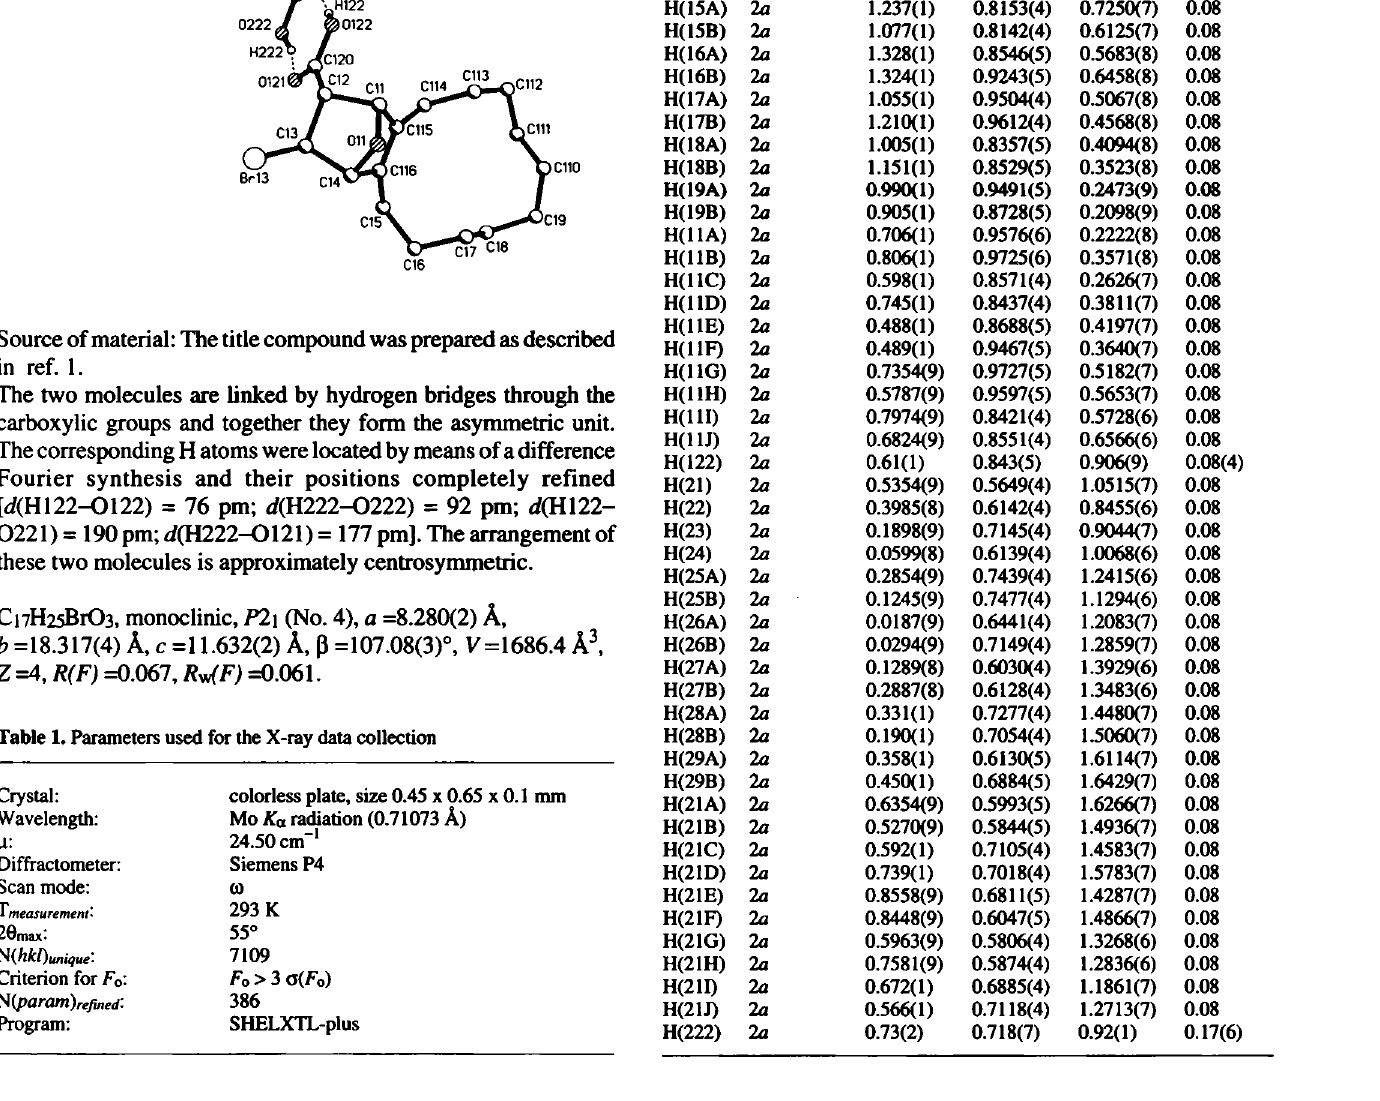
Table 2. Final atomic coordinates and displacement parameters (in